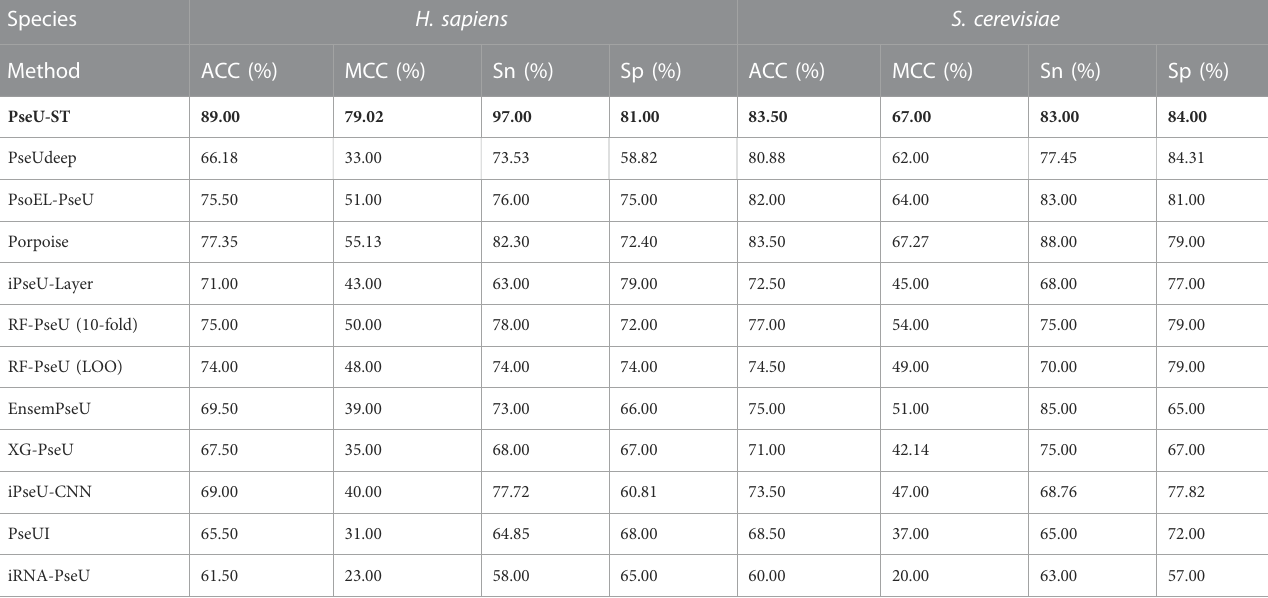
TABLE 5 Performance comparison of PseU-ST and other existing methods on the same independent test datasets. Species H.